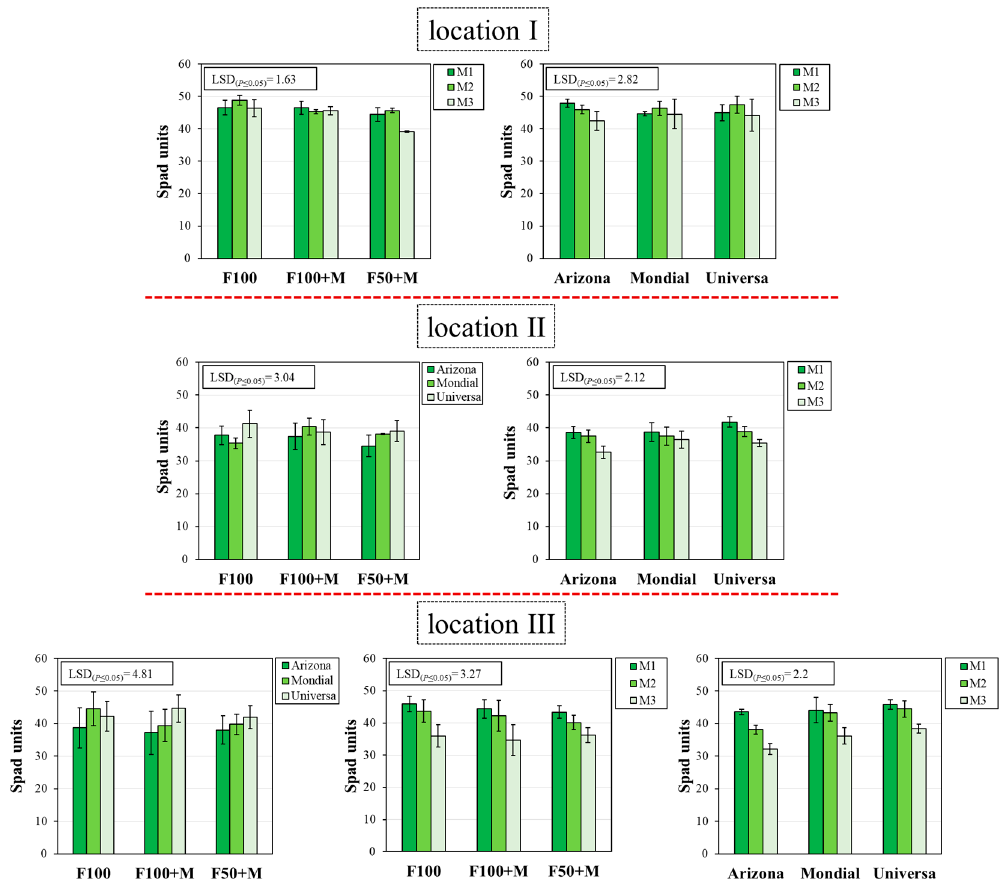
Figure 5. Chlorophyll content (spad units) of leaves of early crop potato organically grown in highly calcareous soils as affected by fertilization management, soil type and potato cultivar. The Least Significant Difference (LSD) interaction was calculated with the Fisher’s protected LSD test at α = 0.05. Each bar indicates means ± standard deviation ( n = 5). F100: optimal fertilization without mycorrhizal inoculation (control); F100+M: optimal fertilization with mycorrhizal inoculation; F50+M: sub-optimal fertilization with mycorrhizal inoculation; ‘Arizona’, ‘Mondial’ and ‘Universa’: potato cultivars. M1, M2 and M3: first, second and third measurement date.